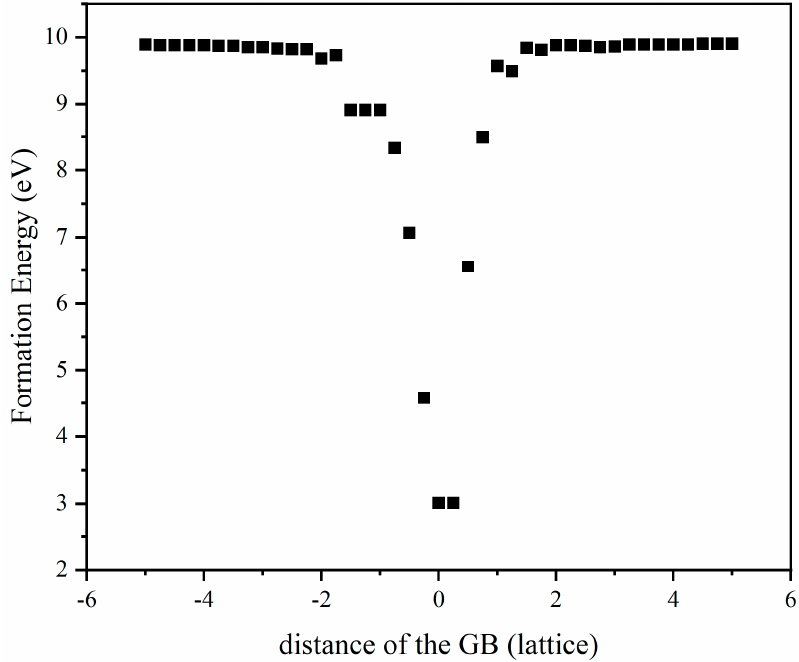
Figure 2. Formation energy of interstitial Xe as a function of the distance from the Σ 5(310) GB.